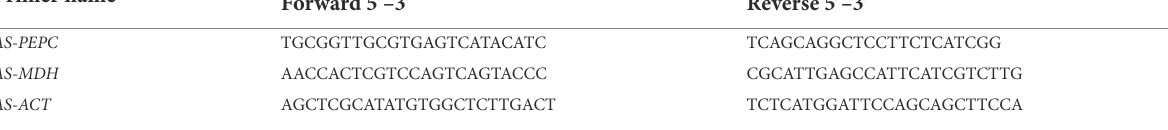
TABLE 1 Sequence of primers used for